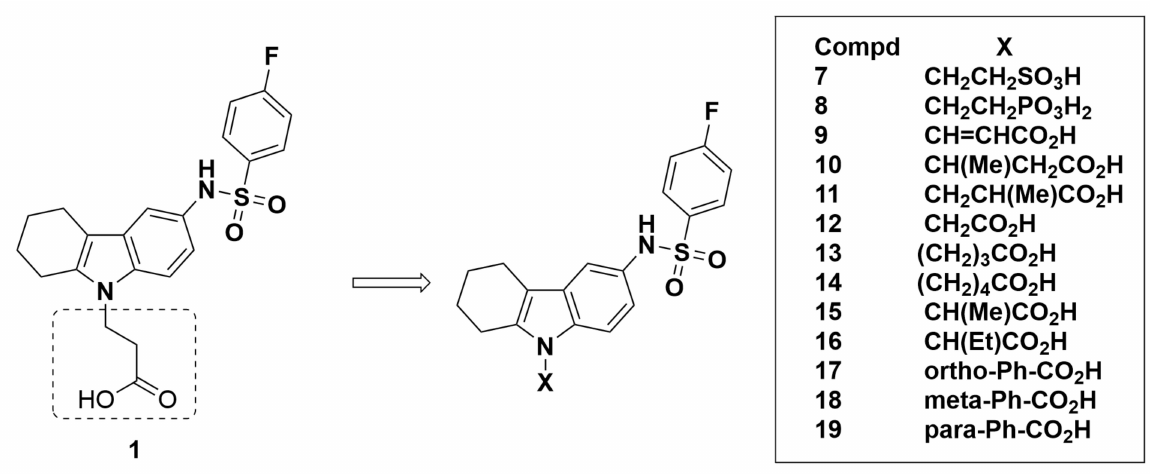
Figure 3. Molecular structures of compounds 7 – 19